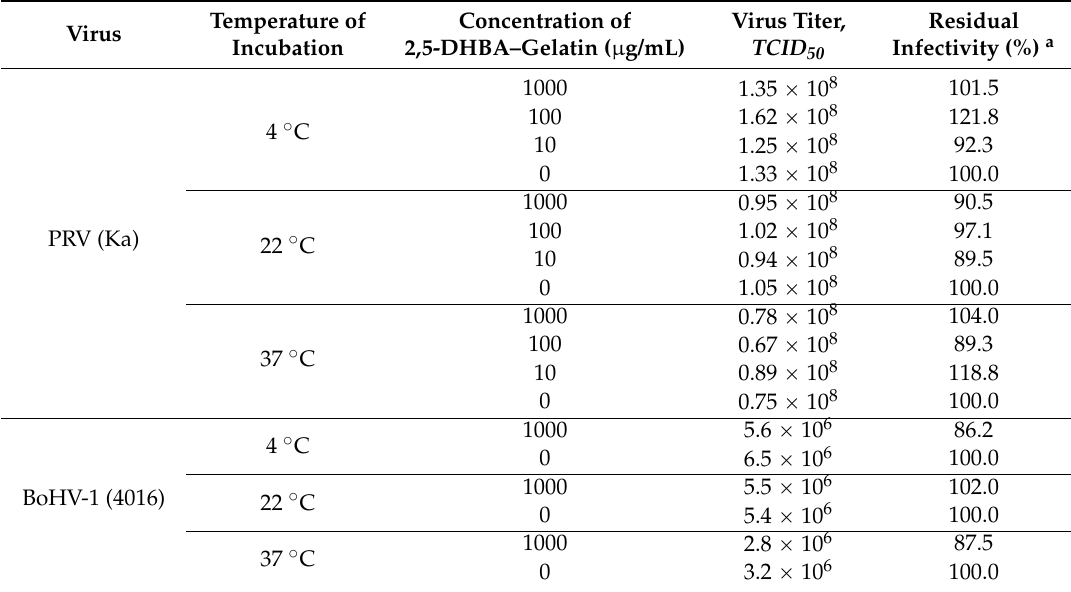
Table 3. Virucidal activity of 2,5-DHBA–gelatin conjugate against PRV and BoHV-1.